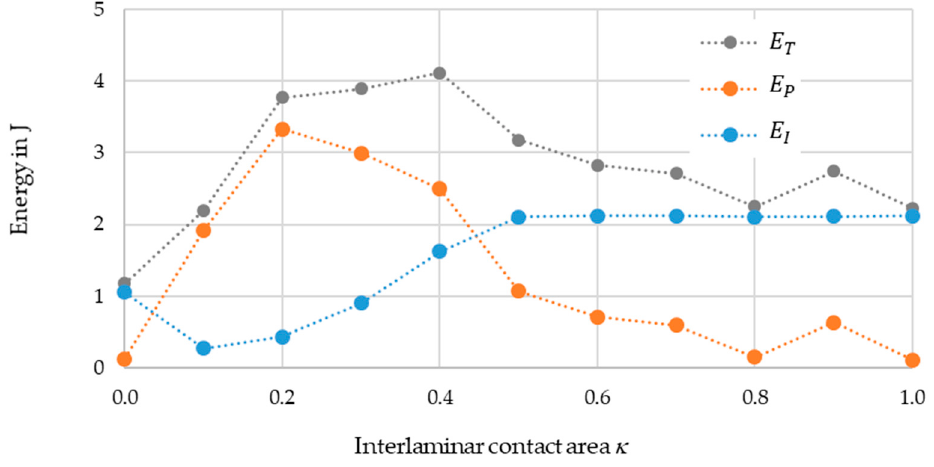
Figure 9. Simulated initial E I and propagation energy E P of the three-point bending test for different Figure 9. Simulated initial 𝐸 (cid:3010) and propagation energy 𝐸 (cid:3017) of the three-point bending test for differ- Figure 9. Simulated initial 𝐸 (cid:3010) and propagation energy 𝐸 (cid:3017) of the three-point bending test for differ- interface modifications κ i ent interface modifications 𝜅 (cid:3036) . ent interface modifications 𝜅 (cid:3036) .